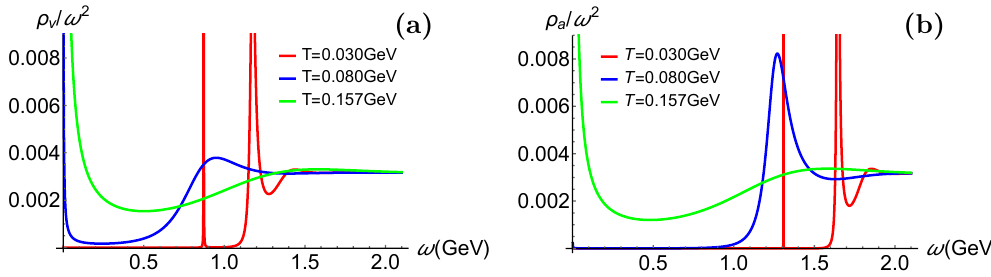
Figure 6 . The spectral functions of (a) the vector meson and (b) the axial-vector meson at T = 0 . 030 , 0 . 080 and 0 . 157